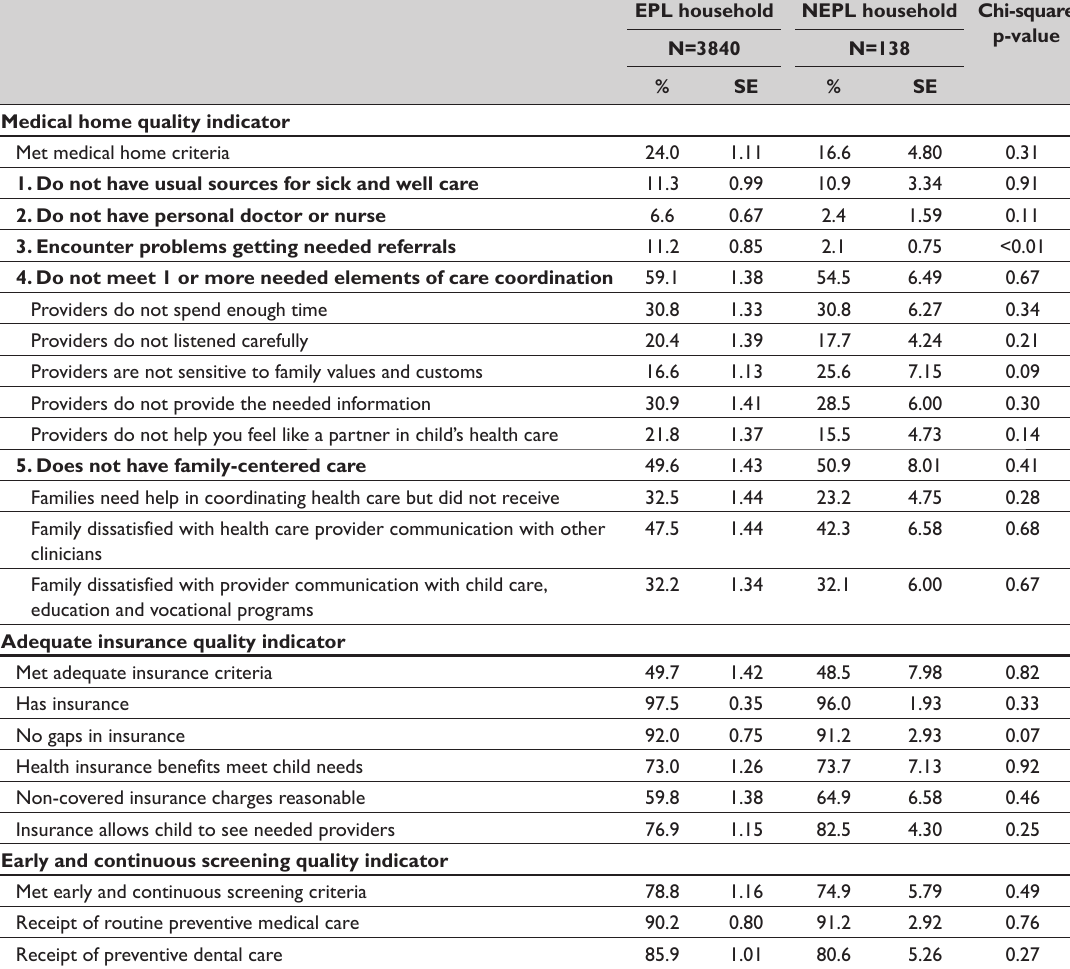
Table 2. Observed (Weighted) Prevalence of Medical Home, Adequate Insurance, and Early and Continuous Screening Quality Indicators among Children with Autism Spectrum Disorders